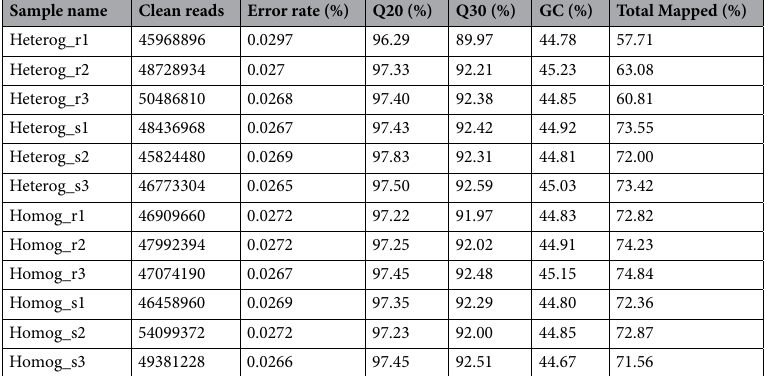
Table 2. Sample libraries sequencing data statistics.